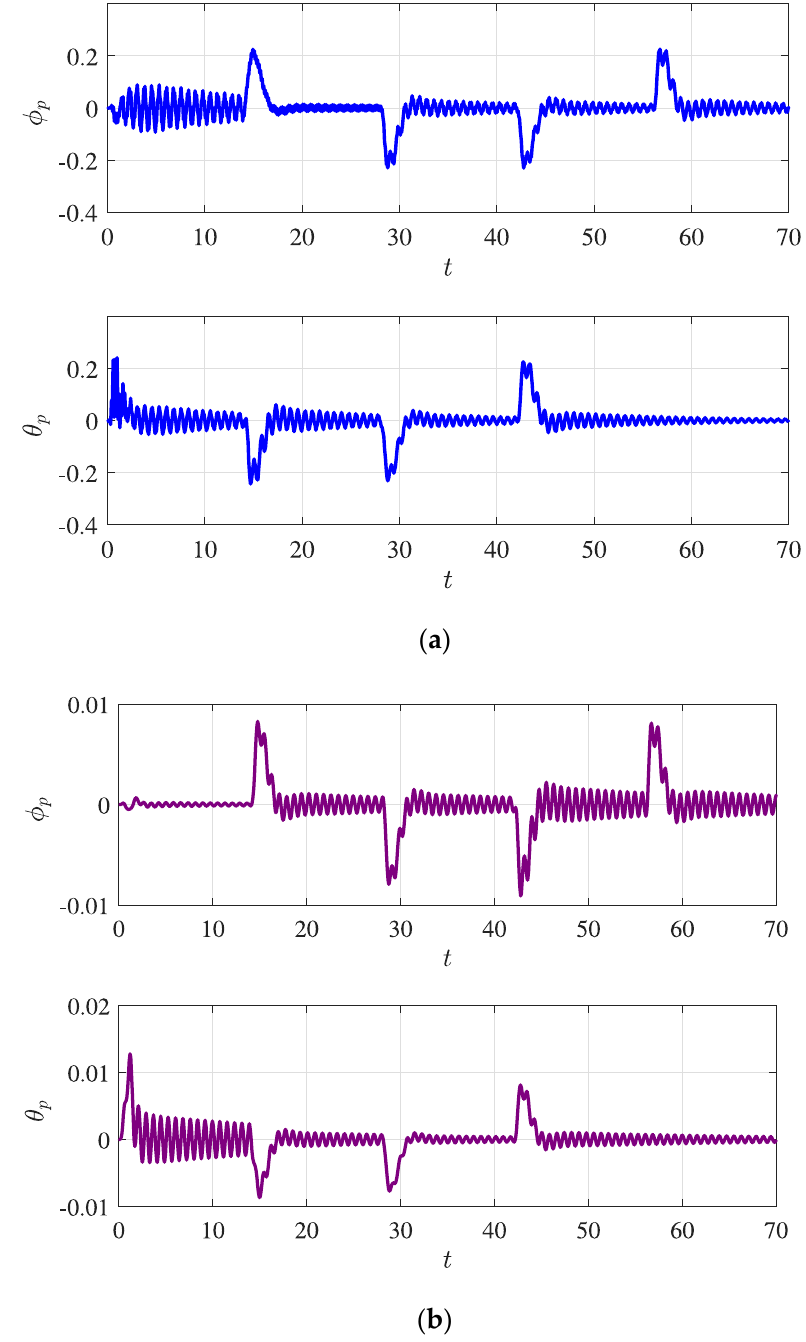
Figure 8. Swing load dynamics, showing the ( a ) elastic attachment (solid blue line) and ( b ) rigid attachment (solid purple line).